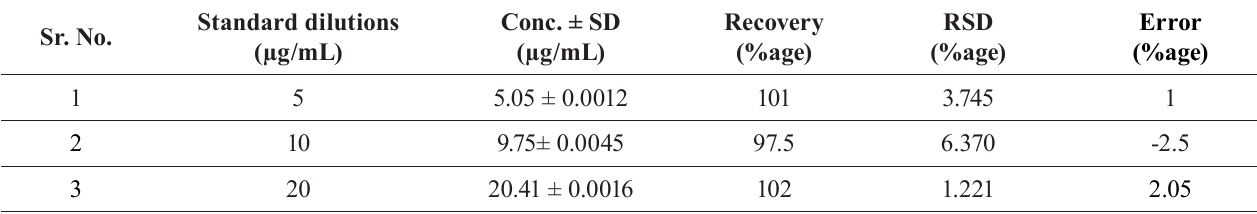
TABLE III - Intraday accuracy and precision analysis (n = 6)